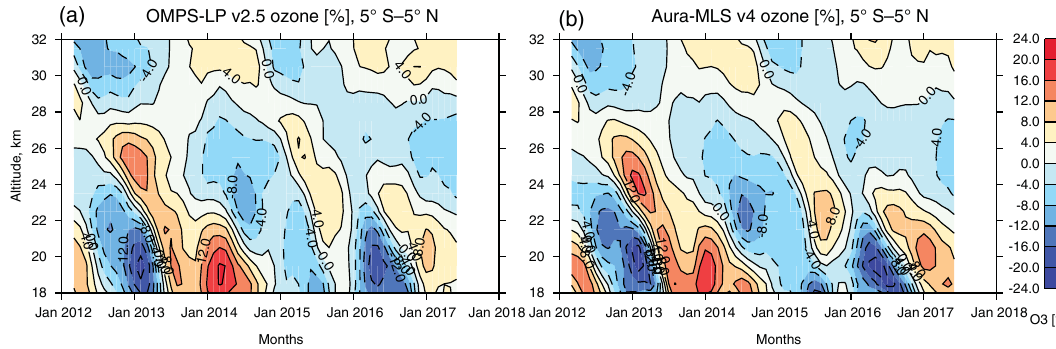
Figure 15. Deseasonalized ozone anomalies over the equatorial latitudes (5 ◦ S–5 ◦ N) for OMPS LP (a) and Aura MLS (b) . The quasi- biennial oscillations (QBO) drives ozone distribution in the tropics. The anomalous disruption of equatorial zonal wind in late 2015 and 2016 led to changes in the tropical ozone distribution. These figures show that the two instruments show very similar responses in ozone to the anomalous QBO